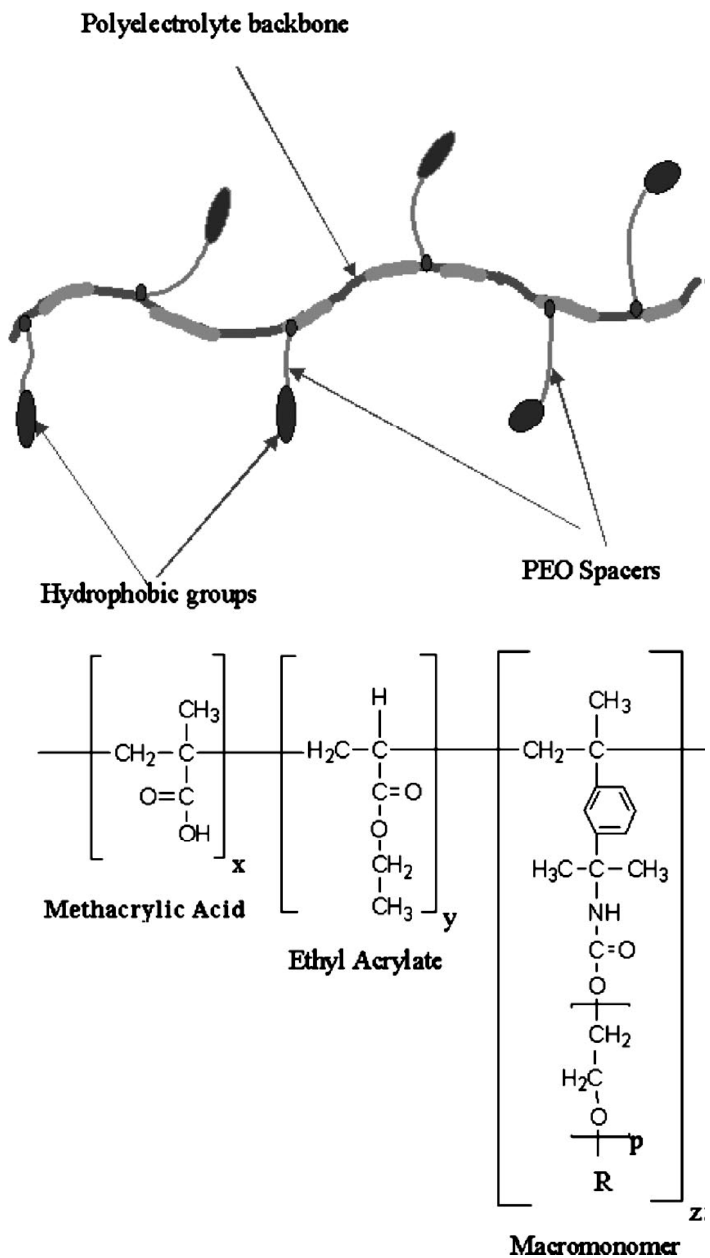
Figure 15. Schematic representation of a typical HASE polymer together with the molecular constitution of the HASE polymers used in this study. R refers to the hydrophobic groups. x , y , z , and p are structural parameters. Reproduced from [16] with permission, copyright American Chemical Society, 2015.